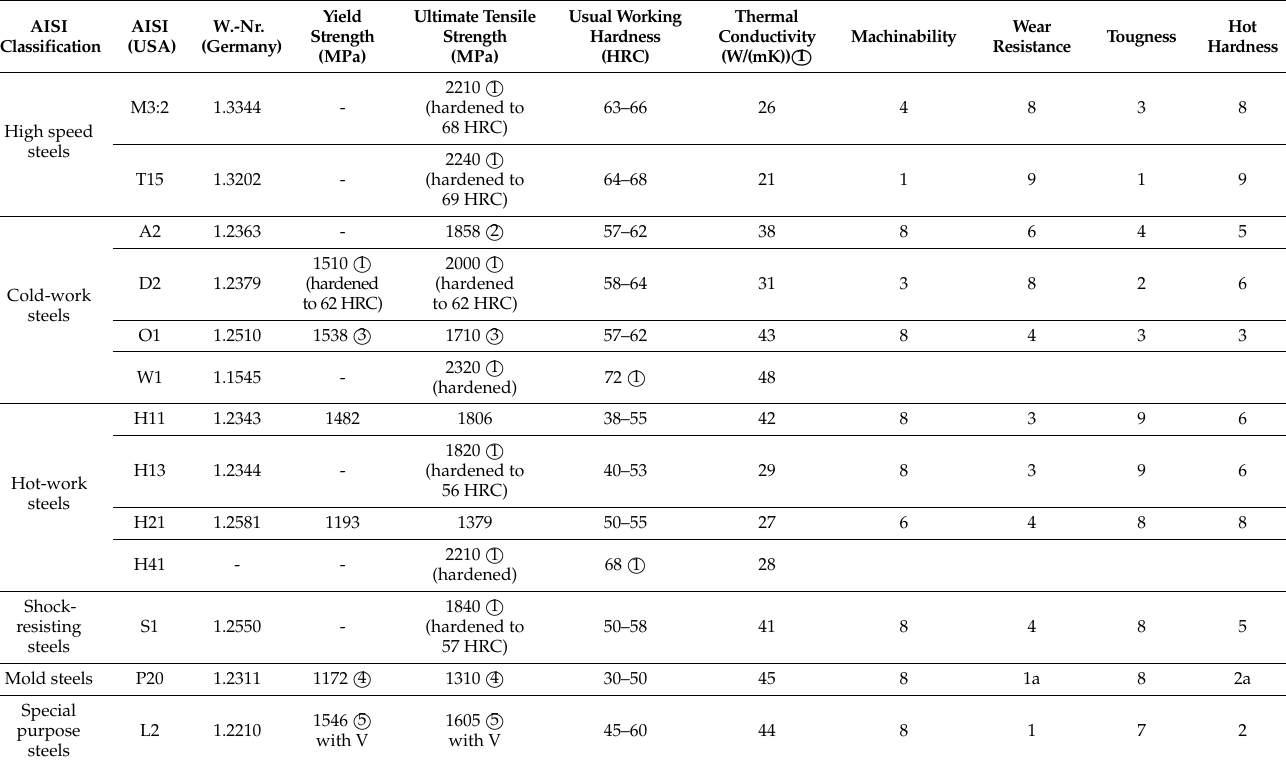
Table 4. Some of the properties of some common conventional tool steels. All values labelled with 1 (cid:13) are from [50]. All other values are extracted from [48].